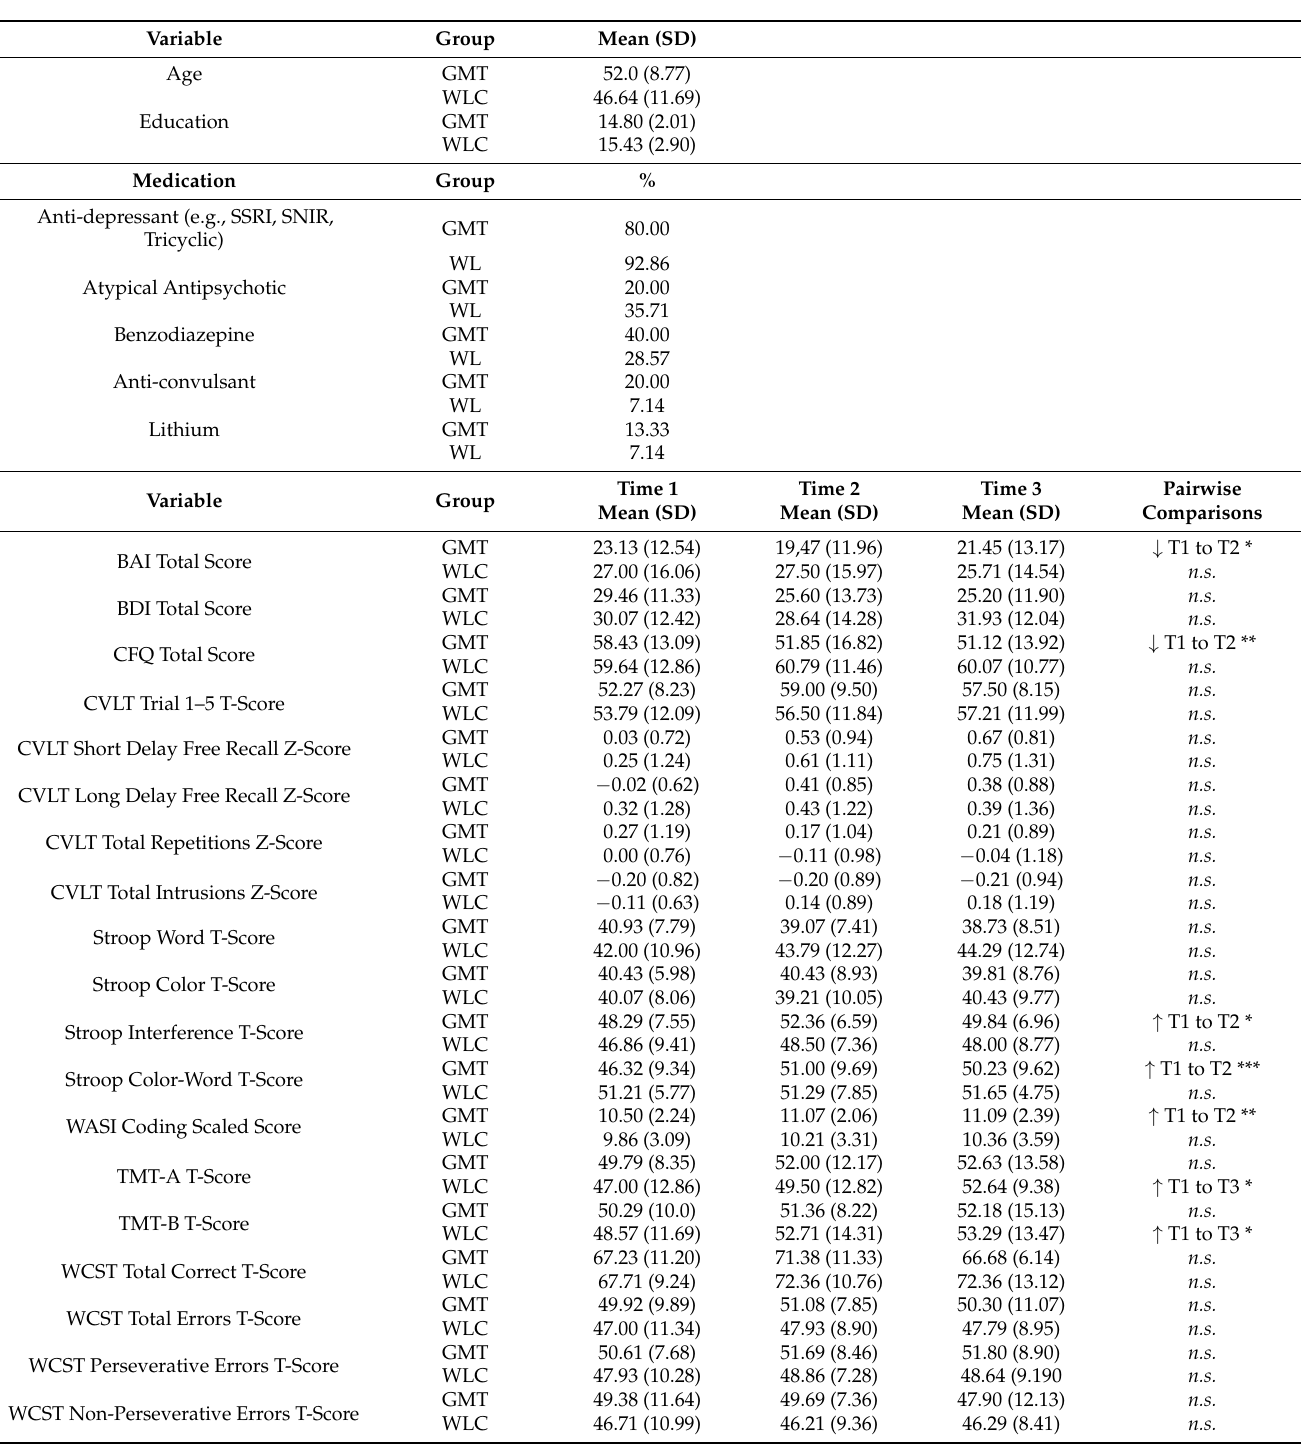
Table 2. Means and standard deviations for participant demographics and outcome variables for baseline, post-treatment and three-month follow-up times, with results of multivariate simple effects of time and pairwise comparison between